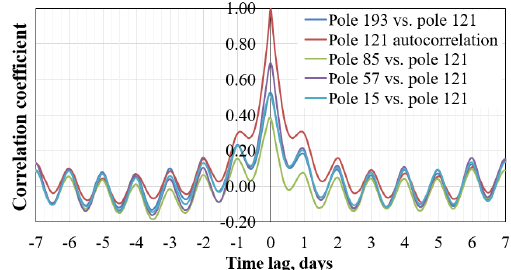
Figure 6. Autocorrelation of wind speed in line pole 121 and its cross-correlations with wind speeds in other line pole